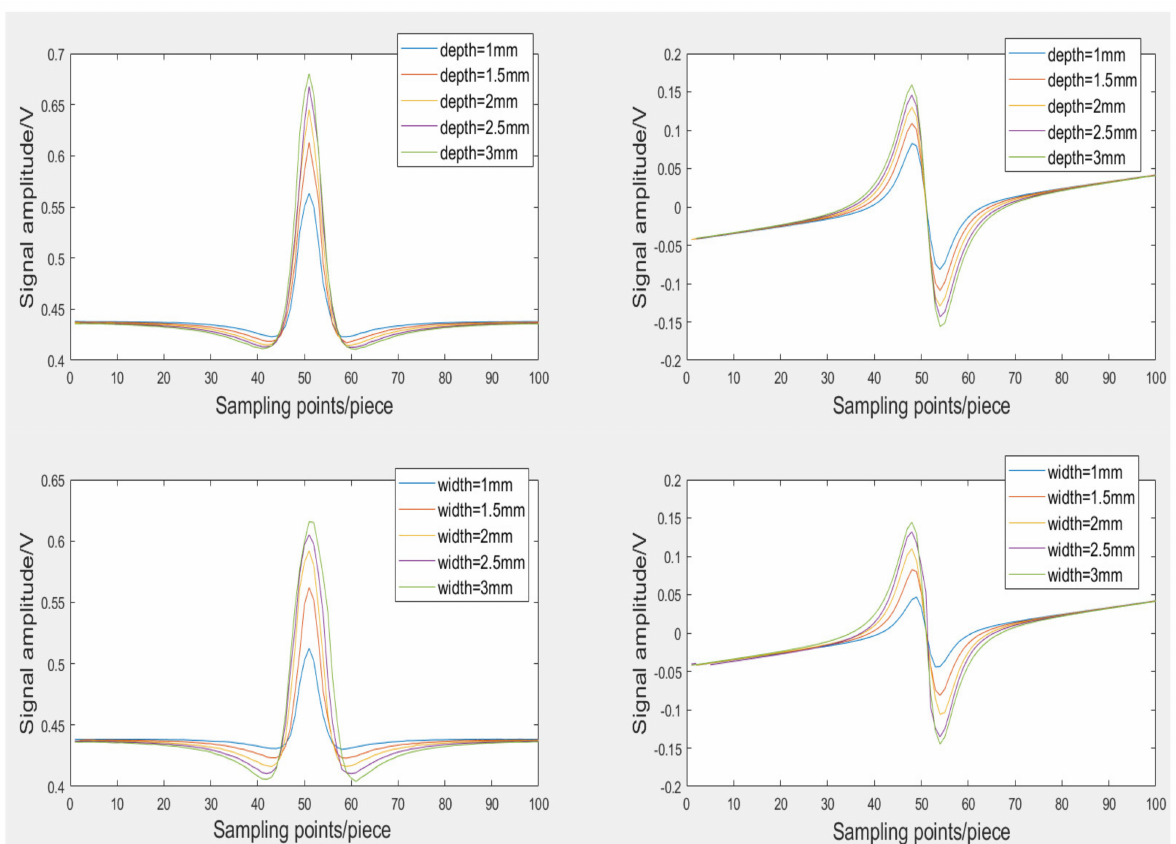
Figure 5. Magnetic field distribution of defects in x and z directions of different